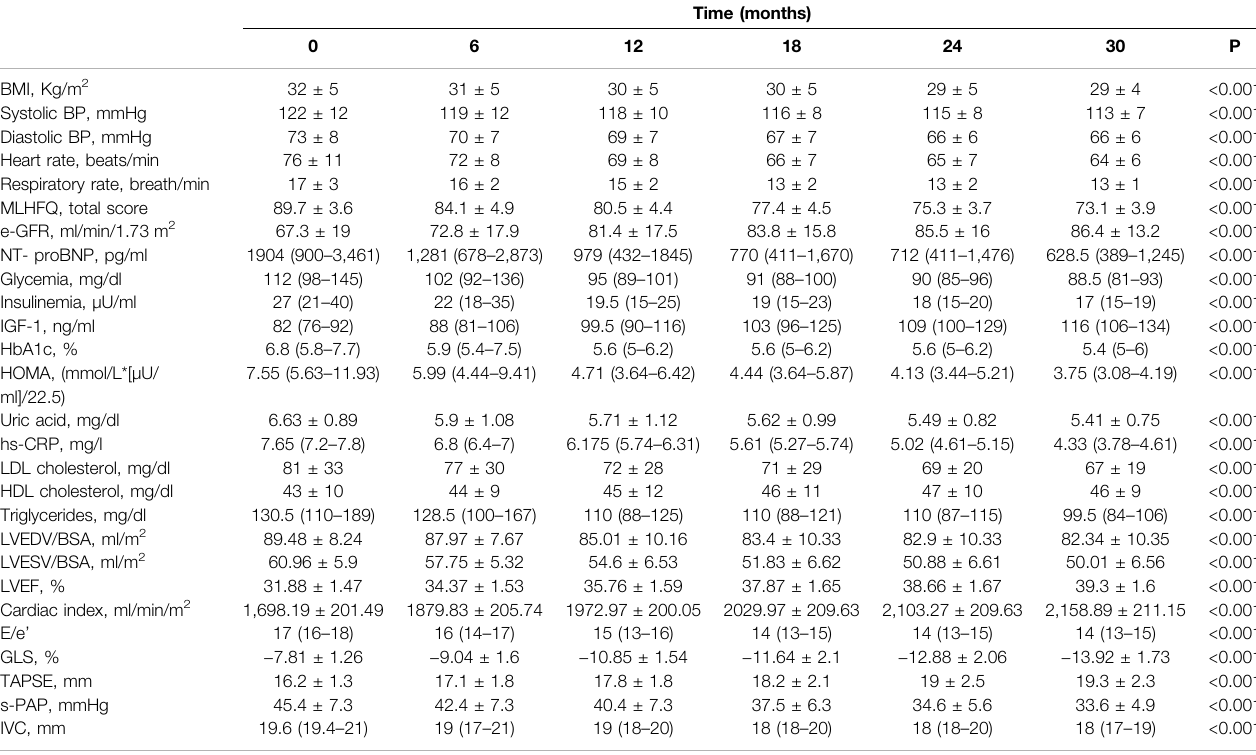
TABLE 3 | Linear mixed models of study variables over